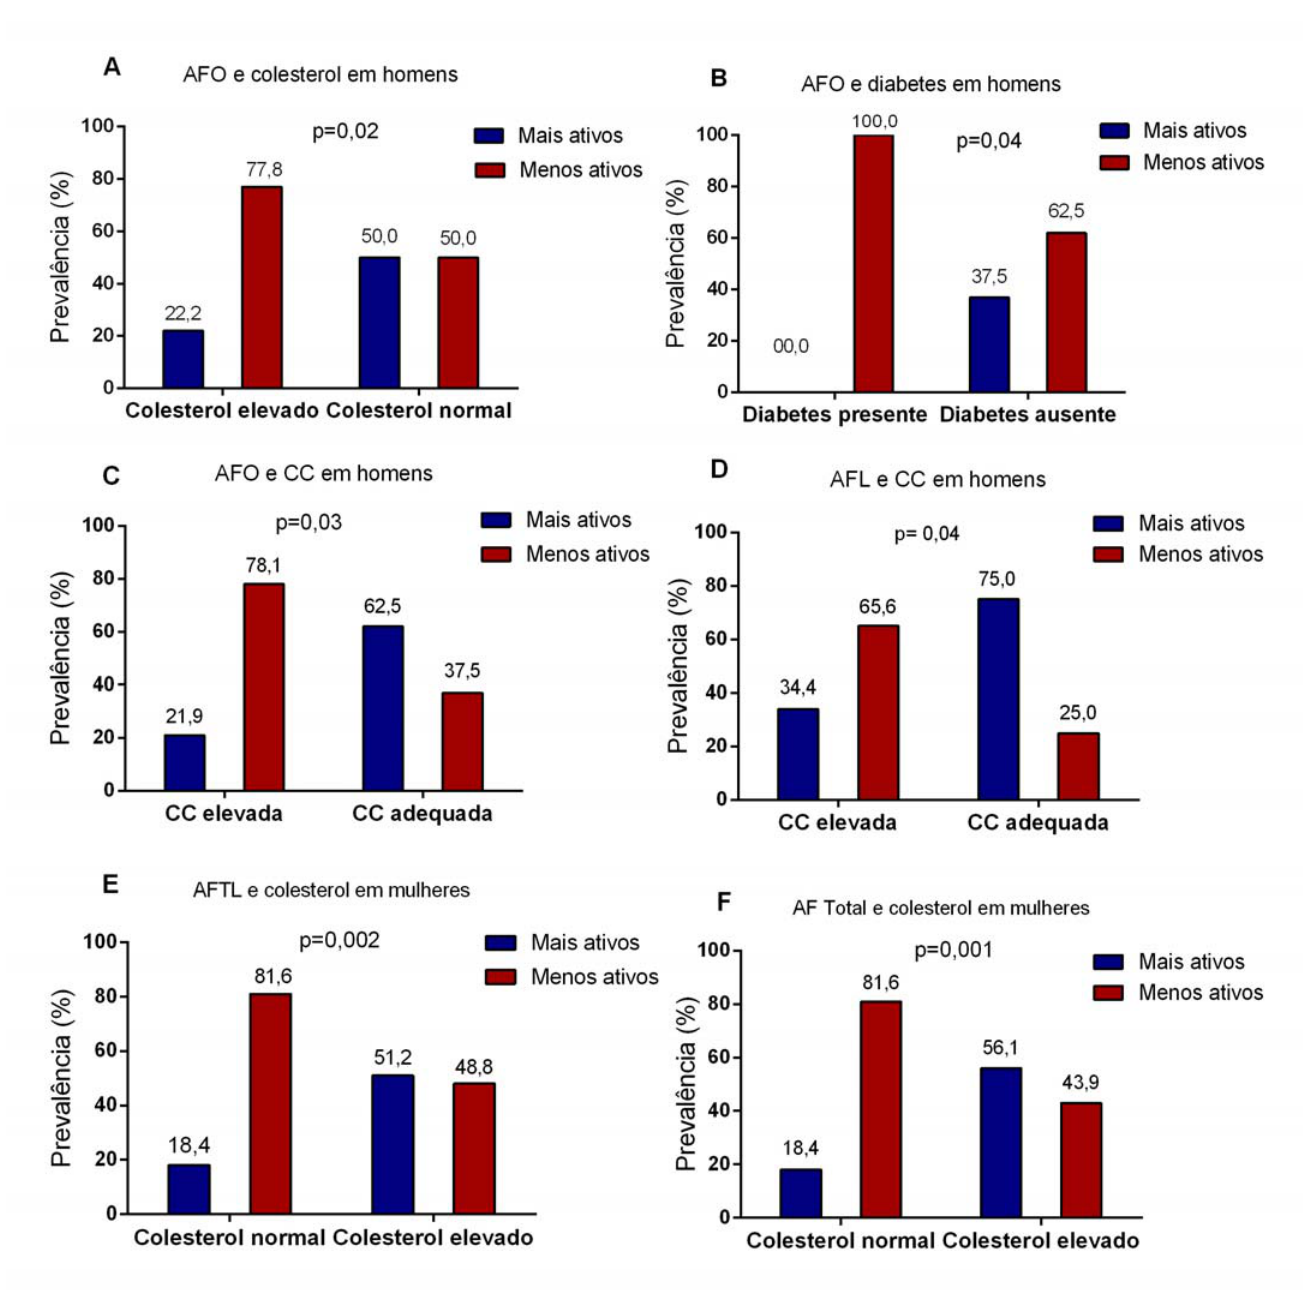
Figura 2. Associações de atividade física com comorbidades, em homens e mulheres com 60 anos ou mais. Legenda: AFO= atividade física ocupacional; AFL= atividade física de locomoção; AFTL; atividade física de tempo livre; CC= circunferência de